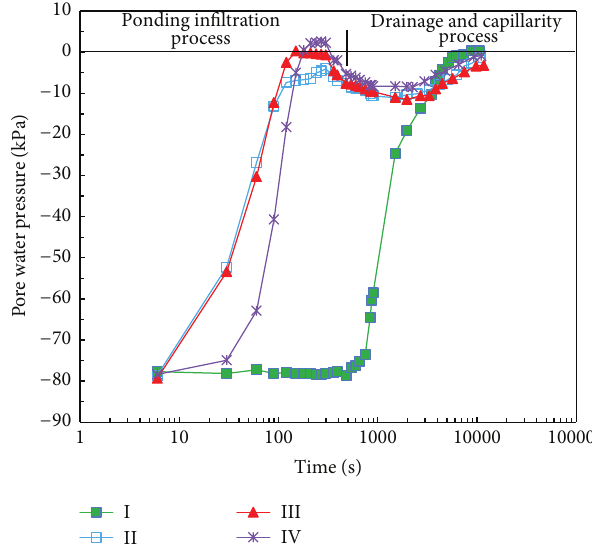
Figure 15: Variations of pore water pressure with time at key points.